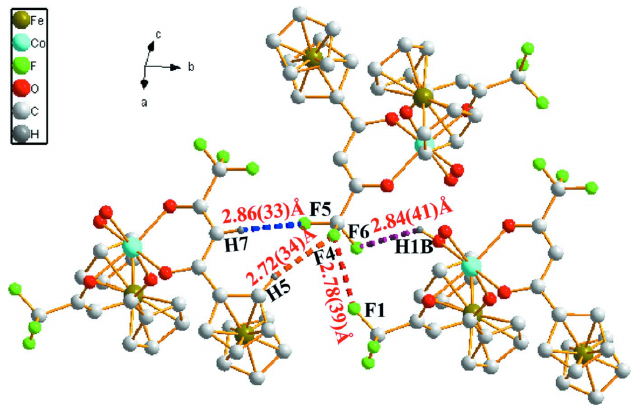
Figure 2 Partial packing diagram of the title compound showing significant H (cid:2)(cid:2)(cid:2) F and F (cid:2)(cid:2)(cid:2) F contacts involving the C10/F4/F5/F6 group as dashed lines.